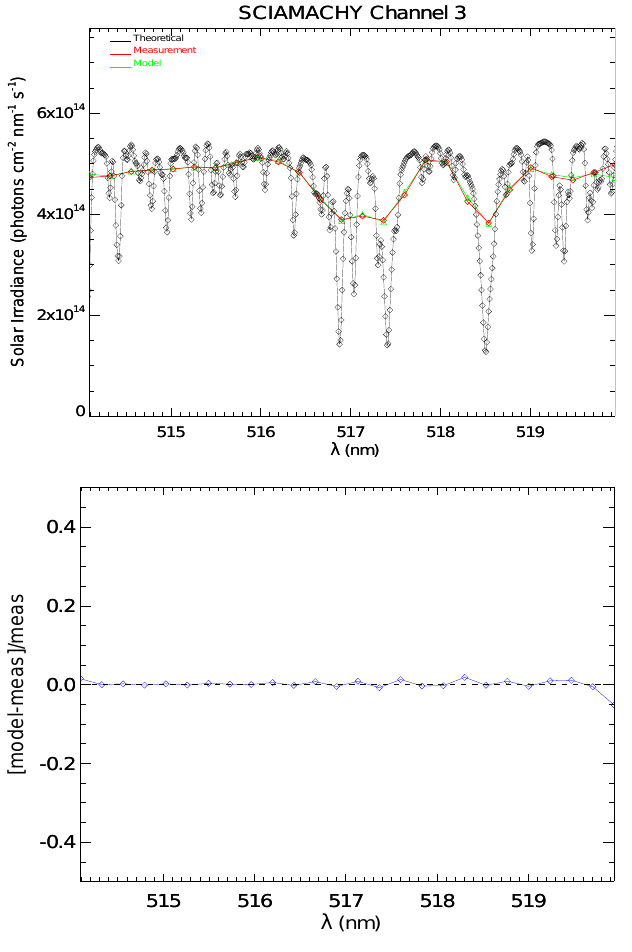
Figure 5. Similar to Figure 3 but for Channel 3 and Line 2. The corresponding retrieved ISRF is a Gaussian with a FWHM (cid:39) 0.43 nm. The residuals ( bottom graph ) rms (cid:39) 0.013.